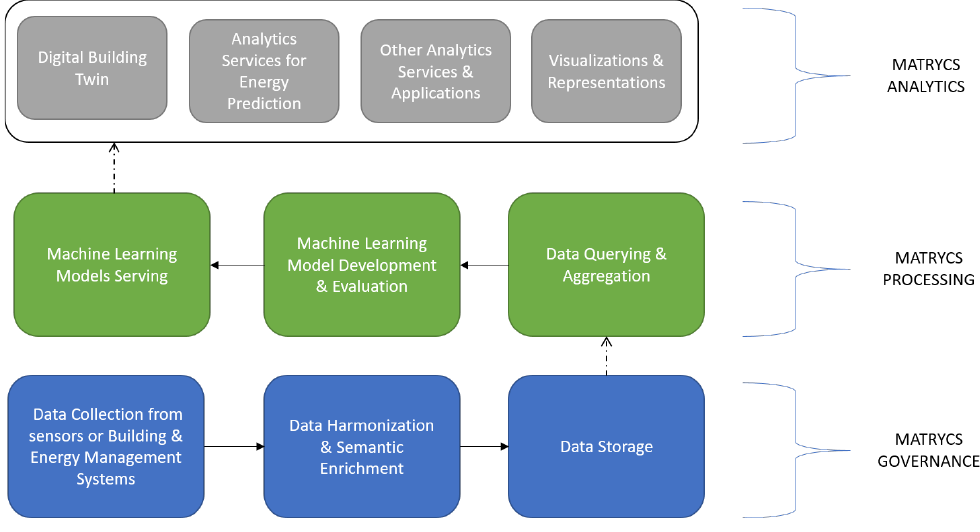
Figure 9. Data flow over the MATRYCS